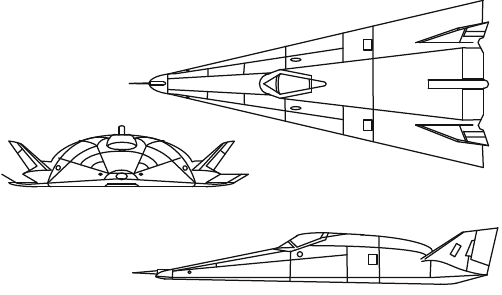
Figure 1: Con fi guration of hypersonic vehicle. Table 1: Parameters of the AHV